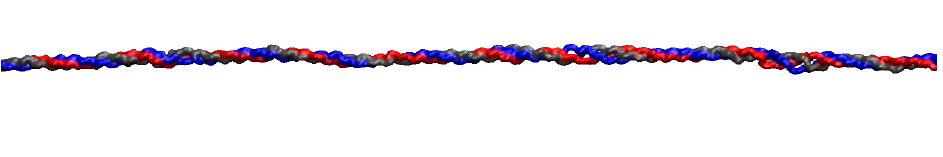
Figure A1. Model of human triple-helix CLG structure devised by homology modeling using MOD- ELLER and shown in VMD with drawing and coloring methods Quicksurf and Chain, respectively. Force field parameters and topology files for HYP were added by editing MOD- ELLER’s library files par.lib , top_heav.lib/top_allh.lib , radii.lib , radii14.lib , and solv.lib . The same CHARMM36m parameters and topology for HYP used here were later used for the MD